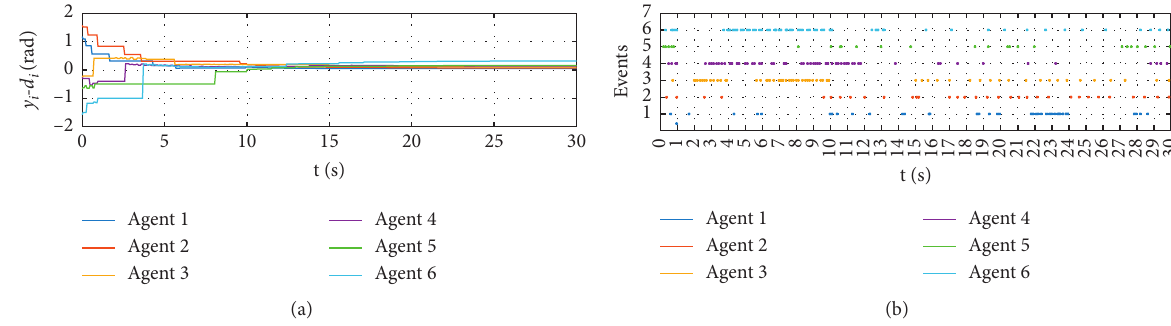
Figure 3: Simulation results of the uniform quantification algorithm in [9]. (a) Represents the evolution of the difference between current angular distance and the desired one between each pair of neighboring agents. (b) Represents the event sequences of N � 6 agents.